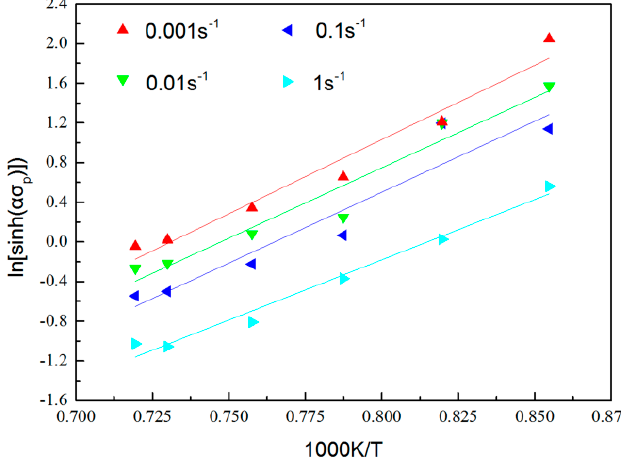
. Figure 6. The relation between ln [sinh( ασ p )] and 1000 K/ T at various strain rates.